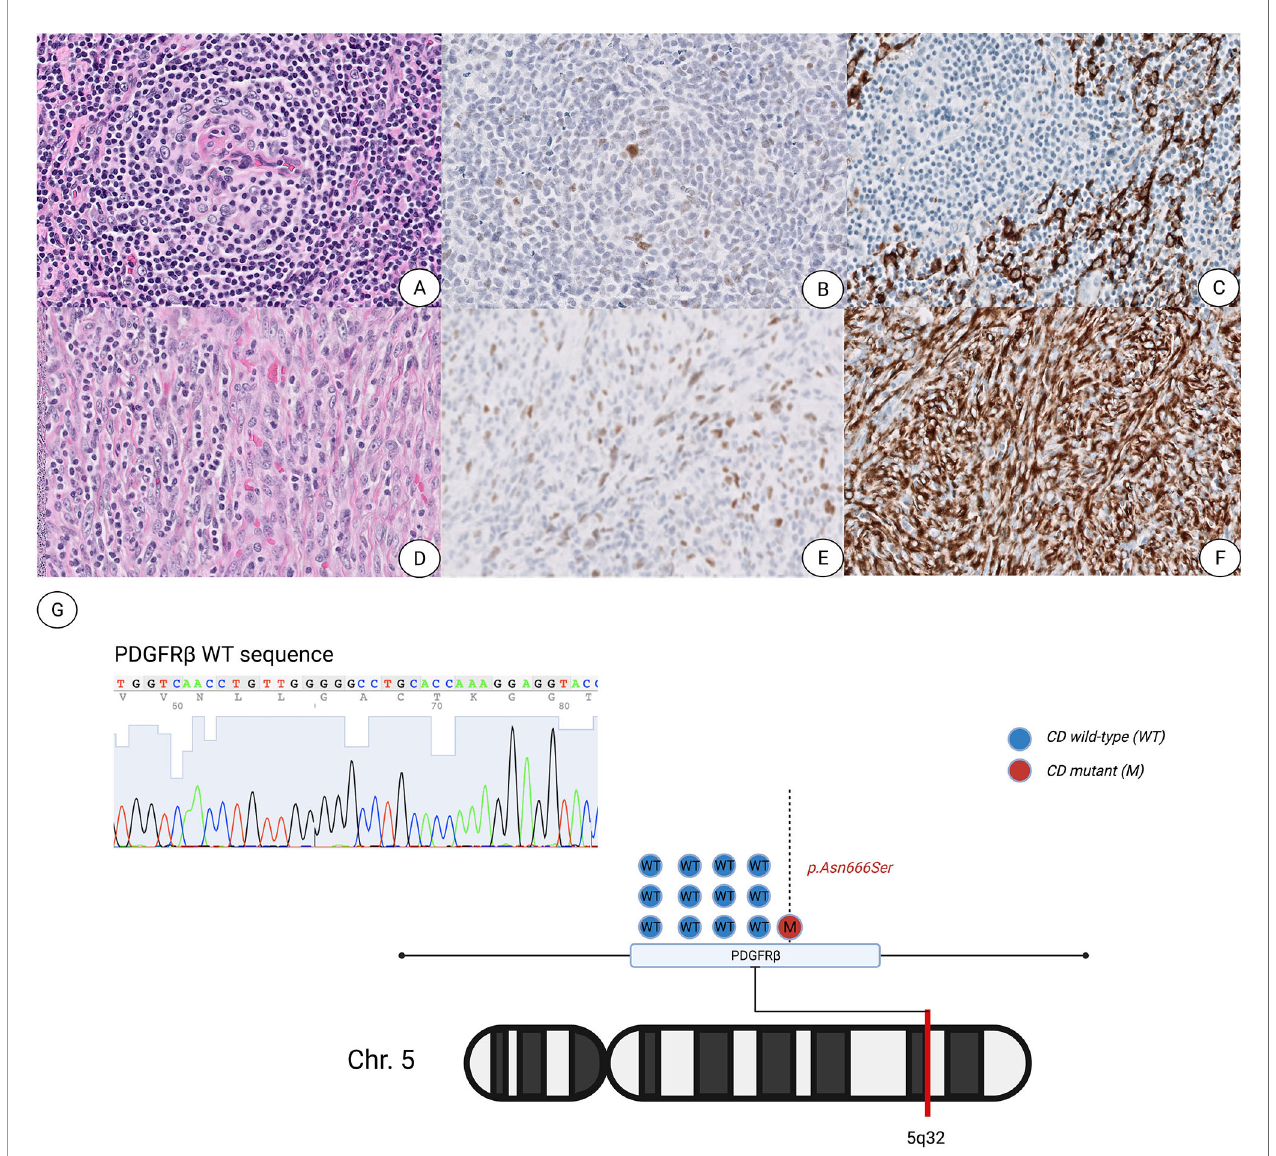
FIGURE 1 | Unicentric Castleman Disease with an associated atypical spindle cell proliferation shows increased p53 protein expression and a PDGFRB p.Asn666Ser mutation. (A – C) Representative images of characteristic atretic follicle showing hyalinization of the germinal center with a penetrating vessel stained with hematoxylin and eosin (A) , p53 (B) and SMA (C) . (D – F) Representative images of spindle cell proliferation stained with H&E (D) , p53 (E) and SMA (F) . All images are presented at ×400 magni fi cation. (G) Graphic illustration of the PDGFRB p.Asn666Ser point mutation located within the 5q32 arm of chromosome